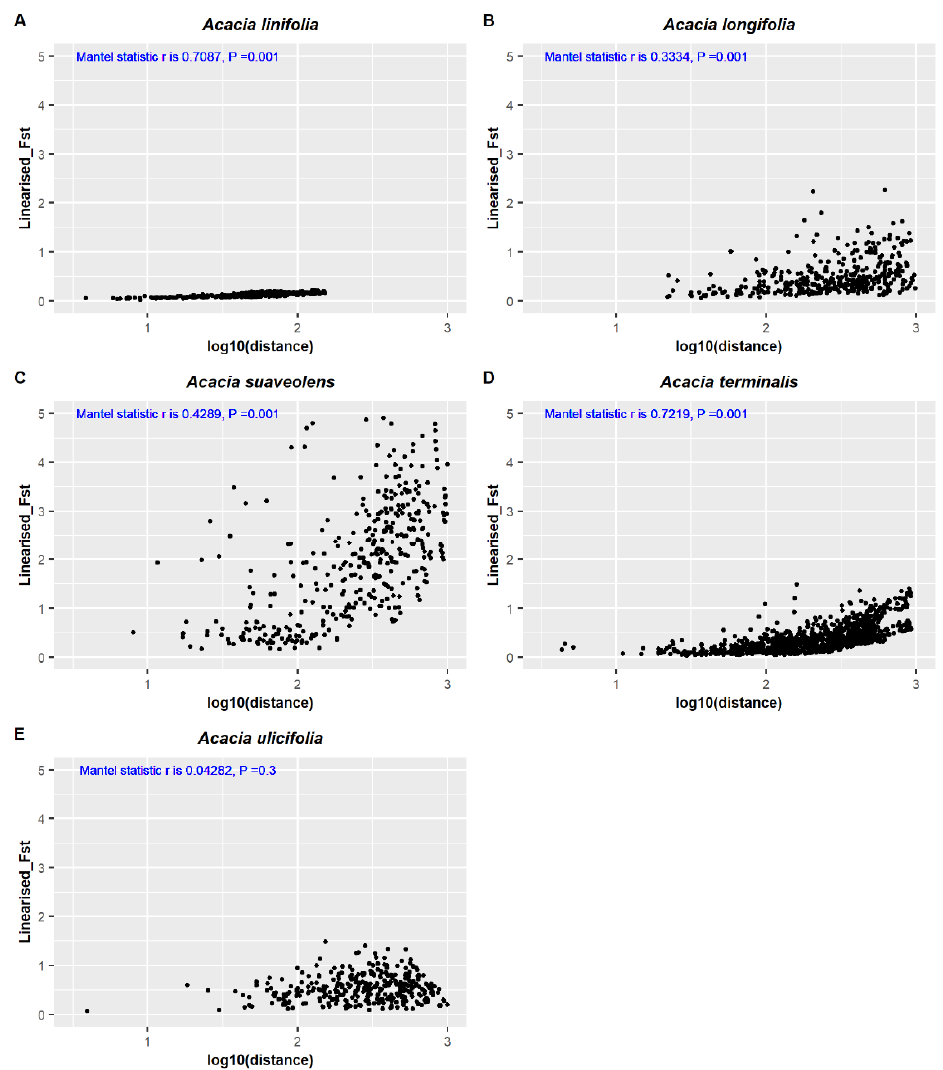
Figure 6. Isolation by distance plots based on pairwise genetic distance (linearized Fst) and geographic distances (log10 transformed) between populations for the five study species. Table 2. Coverage of observed genetic variation across the five Acacia species captured by geographic regions defined by using a GDM, and a generic 20 km radius around the same target site. Coverage was computed as the ratio between the area of a convex hull around samples on a plot of PC1 and PC2, and the area of the convex hull around samples falling within the region.